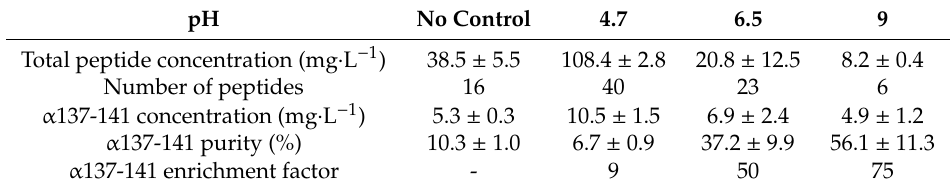
Table 1. Comparison of recovered fractions depending on several working pH values.